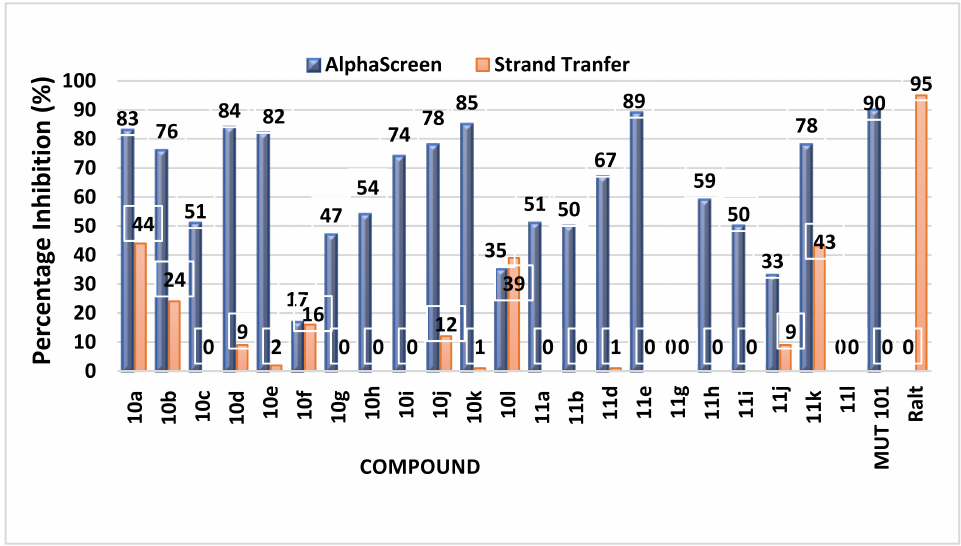
Figure 4. A comparison of carboxylic acid ( 10 ) and carbohydrazide ( 11 ) inhibition percentages in AlphaScreen TM (blue) and ELISA (orange) assays at 100 µ